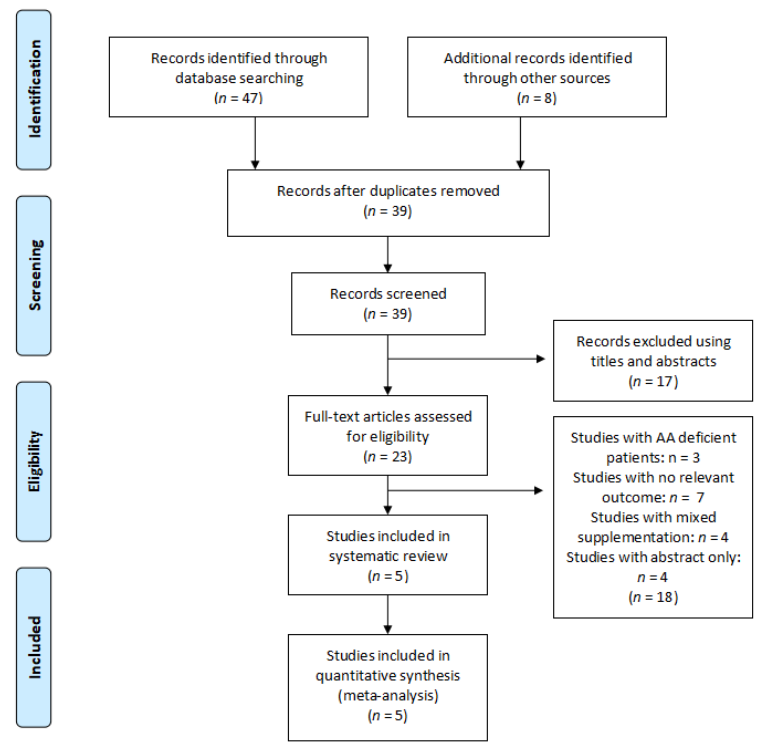
Figure 4. Flow diagram of the search strategy for arginine.